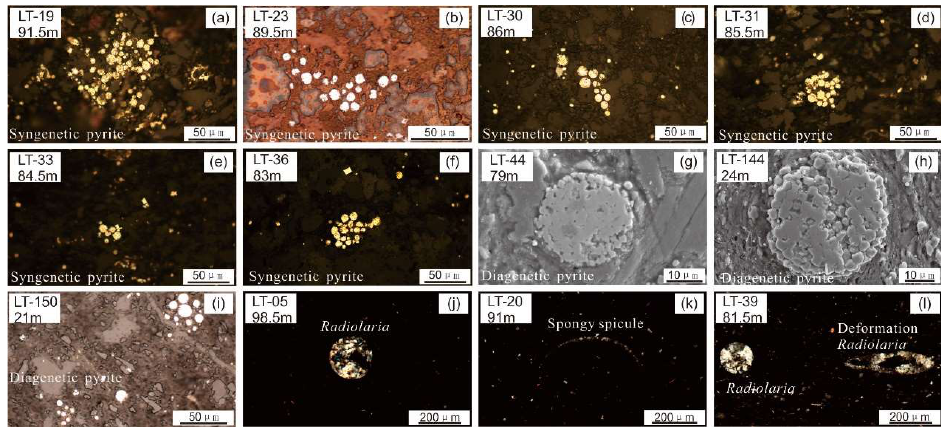
Figure 6. The syngenetic and diagenetic framboidal pyrites and biomarkers unveiled in the strata. ( a – f , i – l ) are photographed under microscopy (+); ( g , h ) are photographed under scanning electron microscopy.